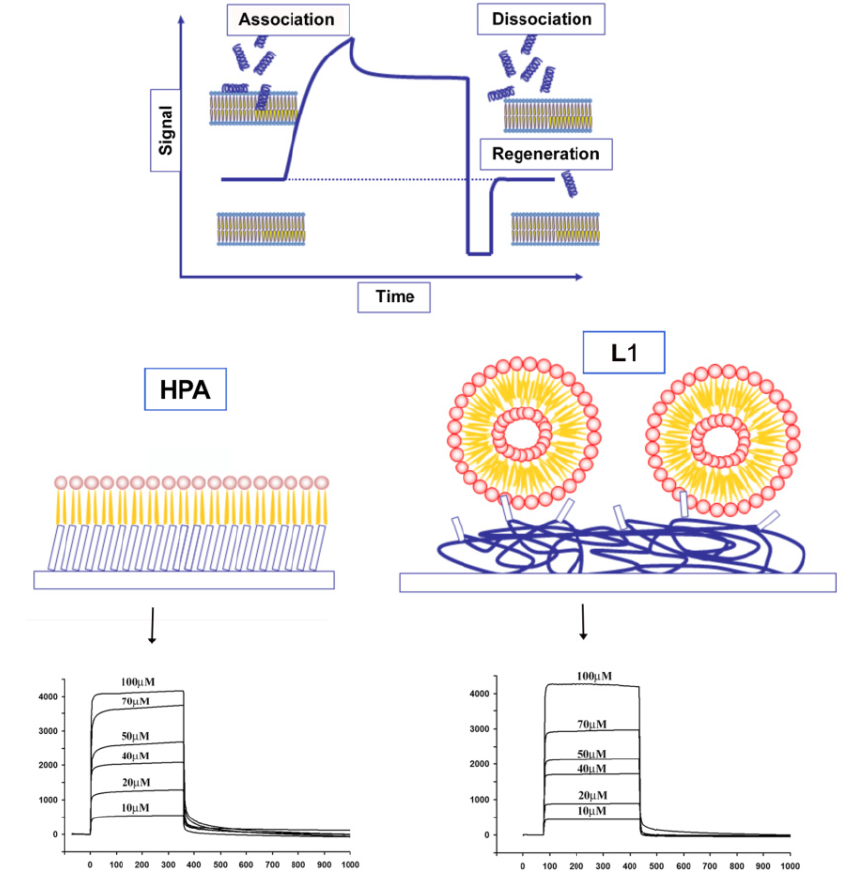
Figure 2. Surface Plasmon Resonance (SPR) and use of different chips for the study of peptide membrane interactions: L1 and HPA. Due to structural differences between the two chips, it is possible to distinguish between surface adsorption in the HPA chip and insertion into the hydrophobic core of the membrane in the L1